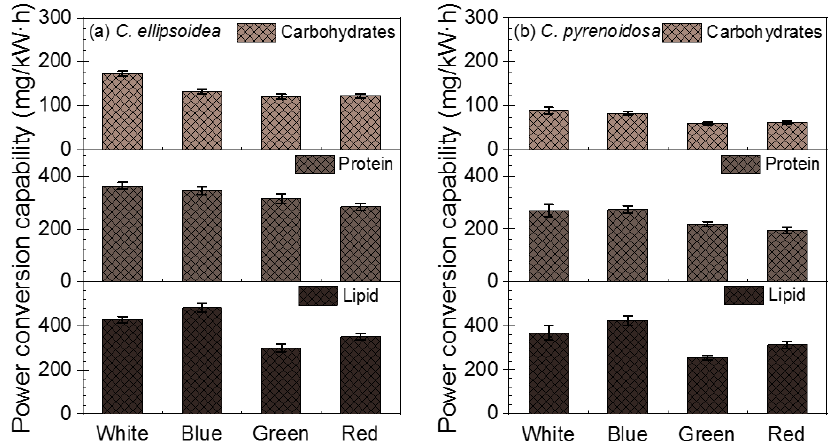
Figure 5. The conversion capabilities of power-to-carbohydrates, power-to-protein and power-to-lipid for C. ellipsoidea ( a ) and C. pyrenoidosa ( b ).